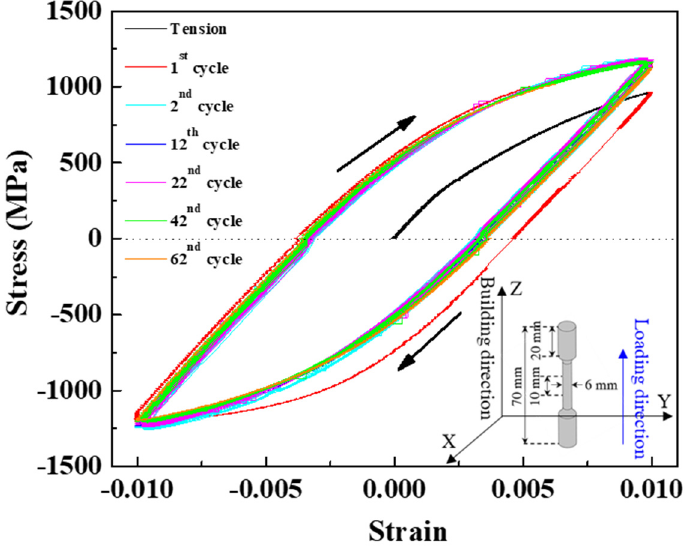
Figure 1. Stress-strain curves under LCF test in the SLM-built 15-5 PH steel. Schematic illustration of the vertically-built SLM 15-5 PH specimen is shown in the inset.